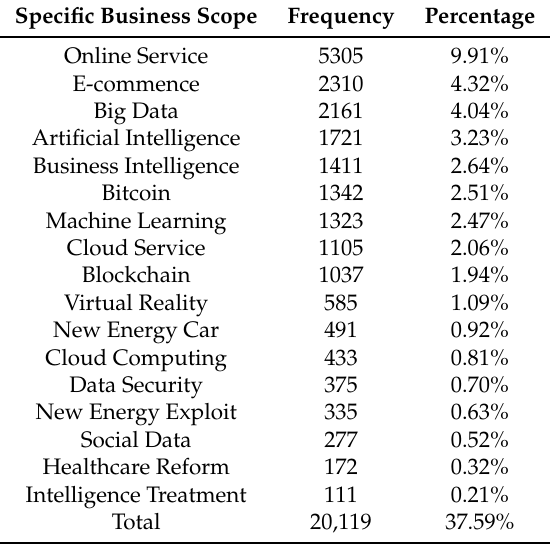
Table 4. Specific business scopes for researched companies.